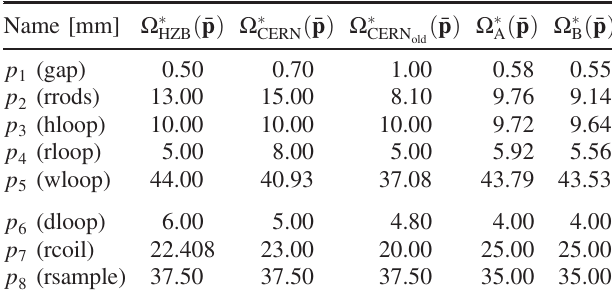
TABLE IV. Results for the MO optimization — parameter domain a